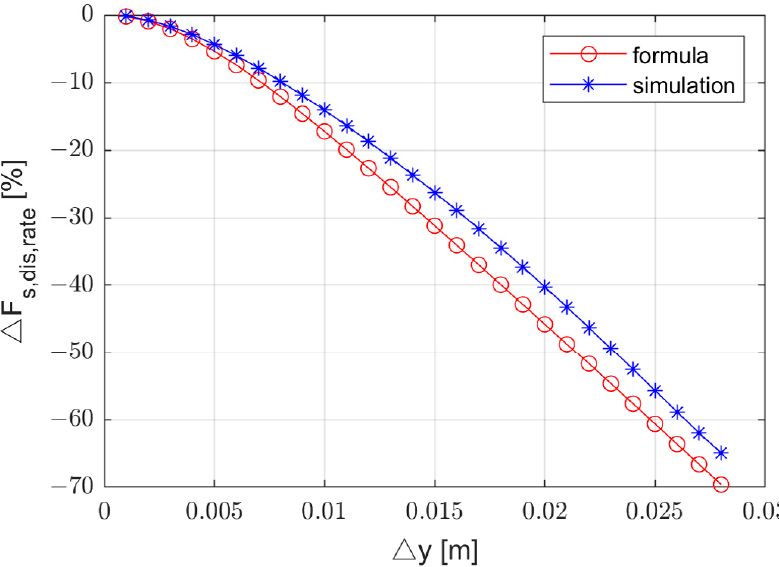
Figure 5. Attenuation ratio of suspension force with different horizontal